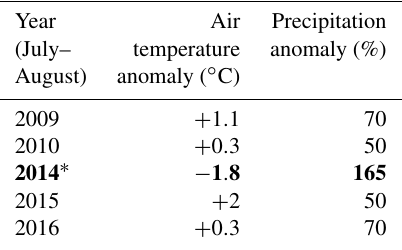
Table 2. Climatic characteristics during years of stream temperature monitoring